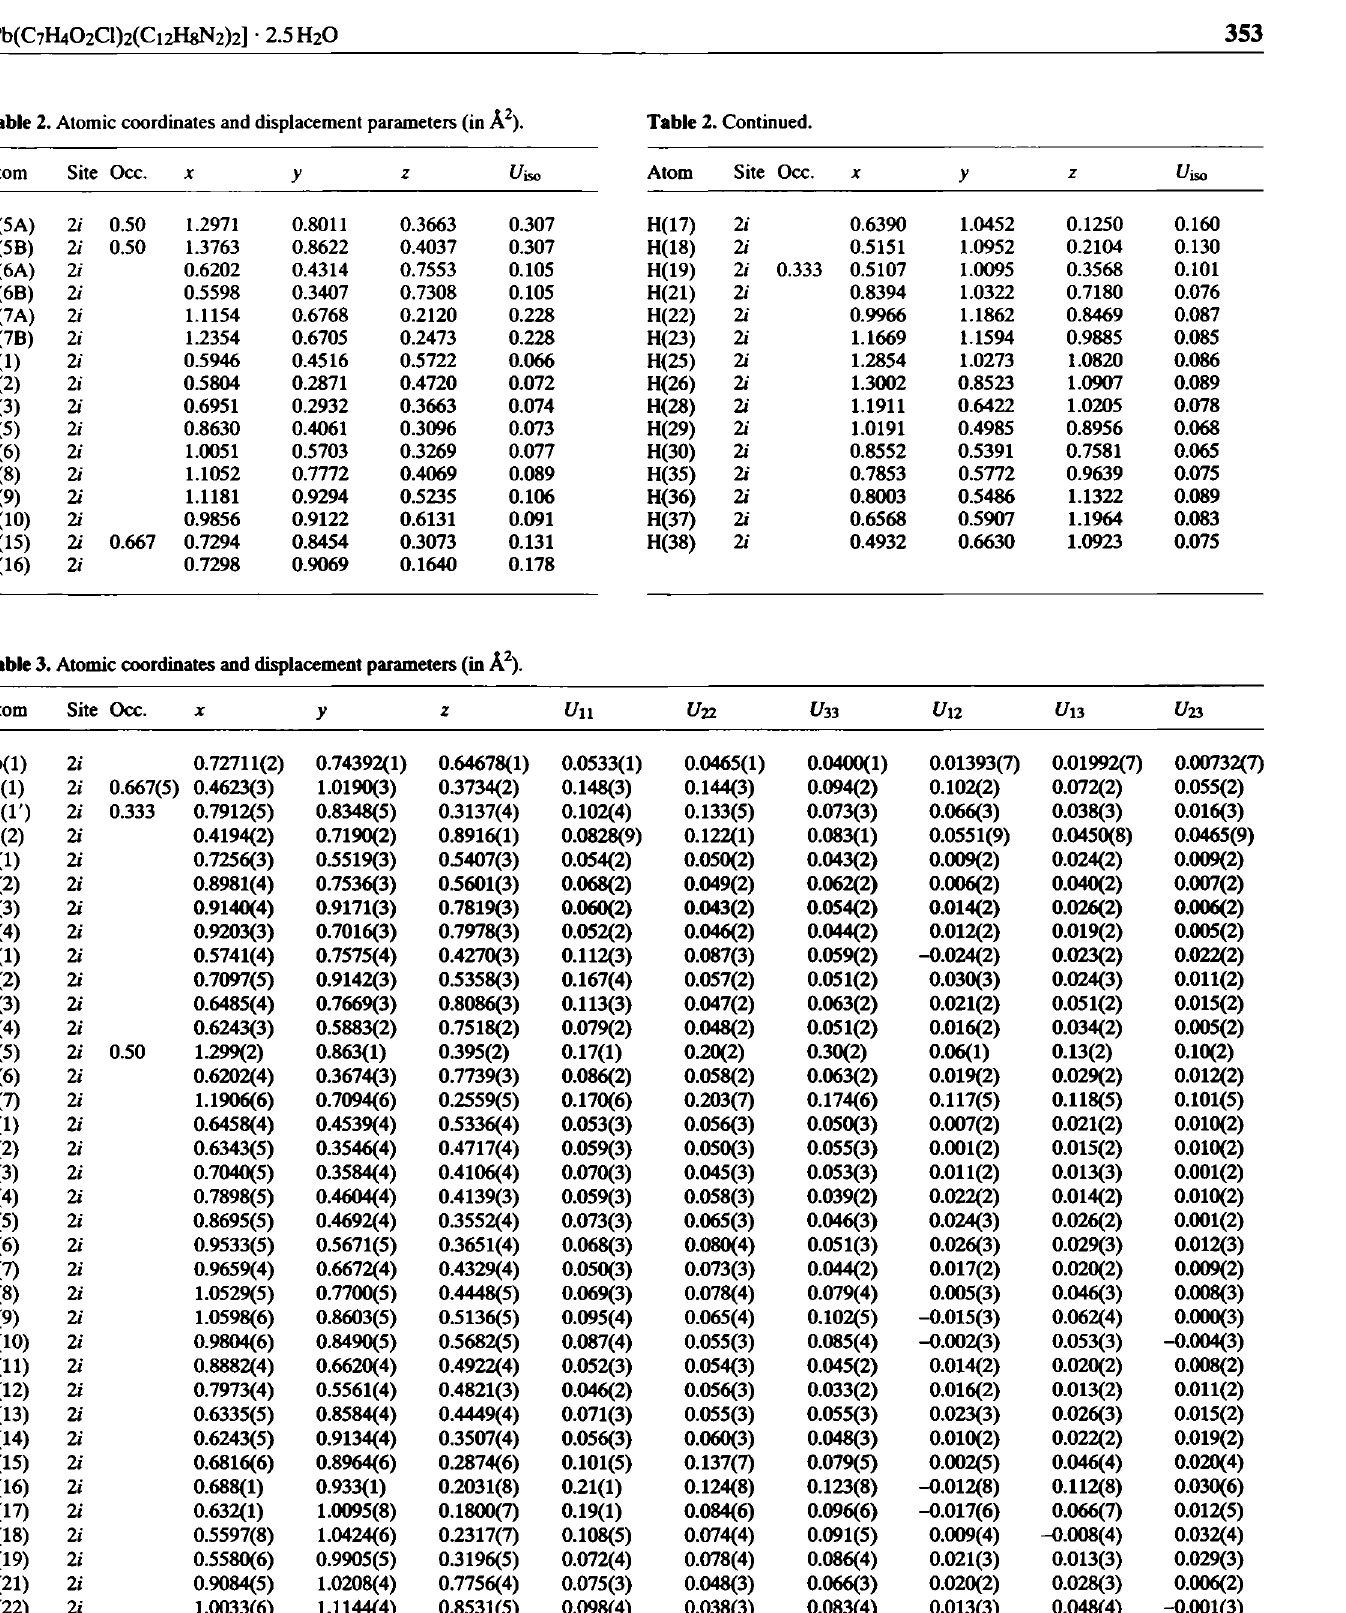
Table 2. Atomic coordinates and displacement parameters (in Ä 2 ).